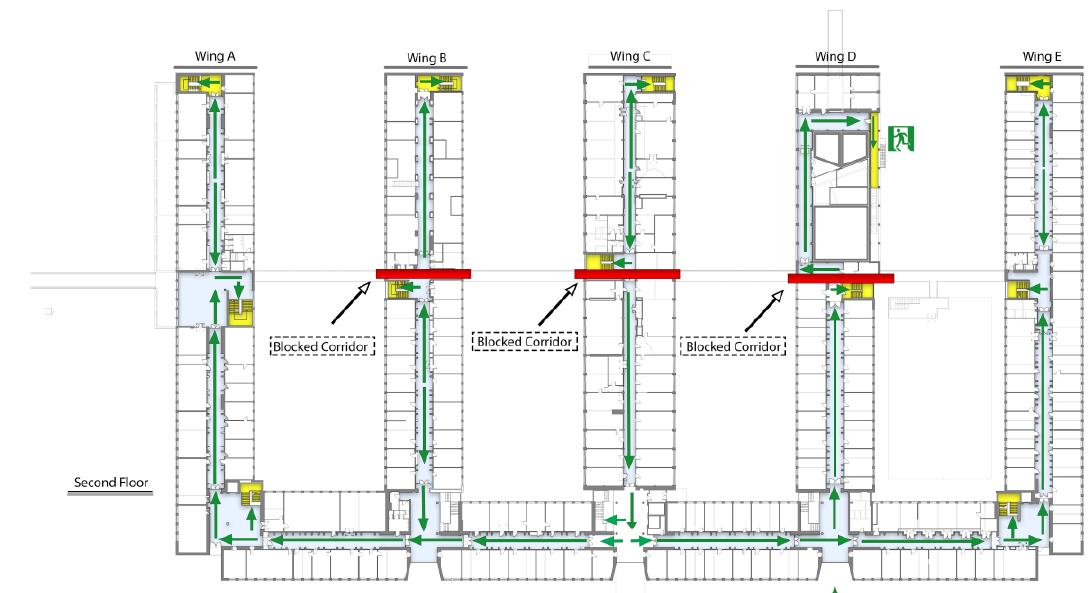
Figure 6. 2D and 3D plans for Scenario A: Bomb